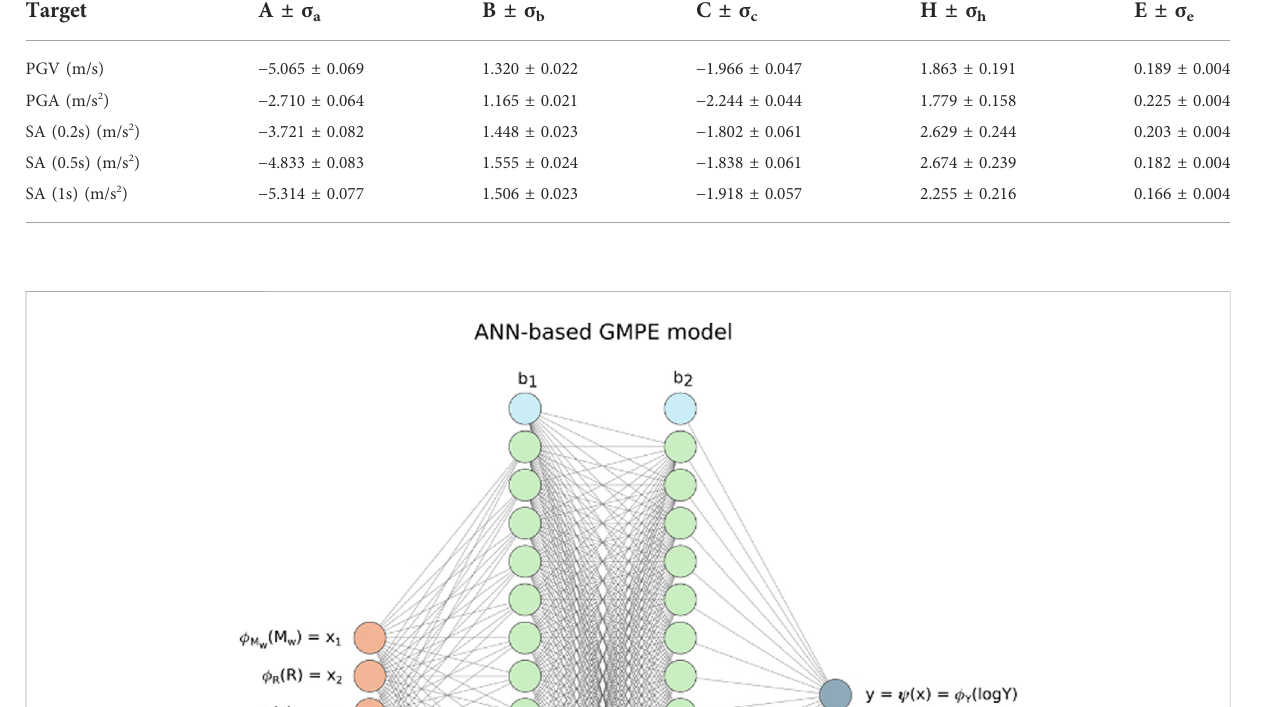
Frontiers in Earth